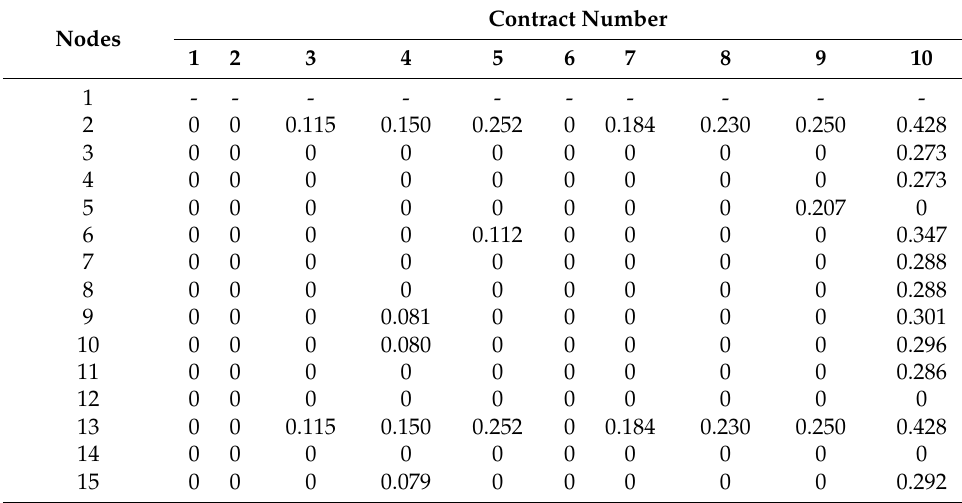
Table 3. Bilateral contract trading volume of each